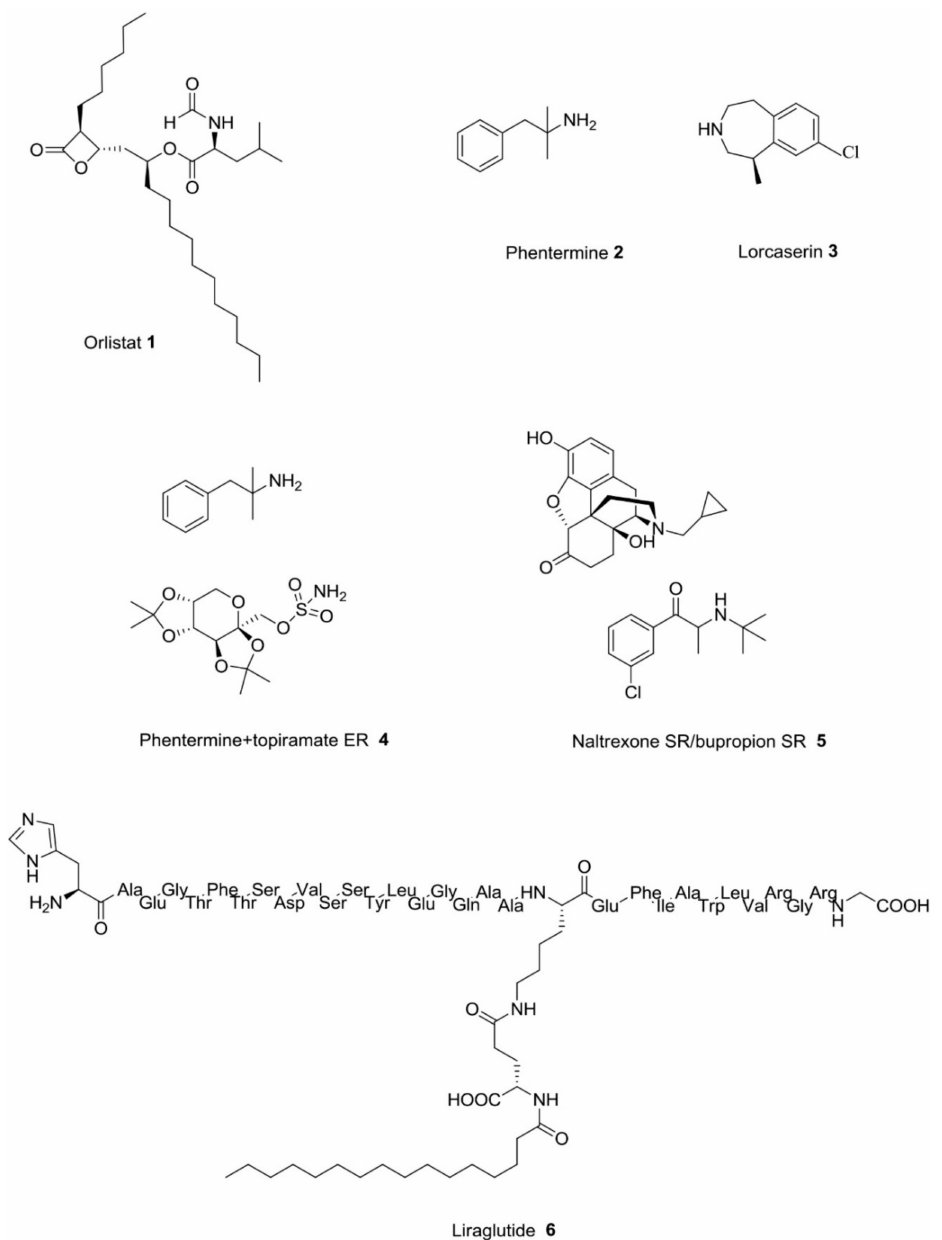
Figure 1. Current commonly used anti-obesity drugs